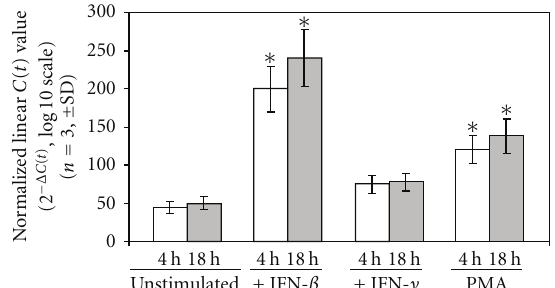
Figure 2: Induction of RGS1 by IFN- β , IFN- γ , and PMA . PBMCs obtained from healthy individuals were stimulated and RGS1 expression determined as described in Section 2. PBMCs were stimulated with IFN- β (1000IU/mL), IFN- γ (1000IU/mL), and PMA (2ng/mL) for the times indicated (white column = 4 hours; gray column = 18 hours post-IFN- β stimulation). All results were normalized to GAPDH and expressed as the mean ± SD, n = 3. ∗ P < . 05.